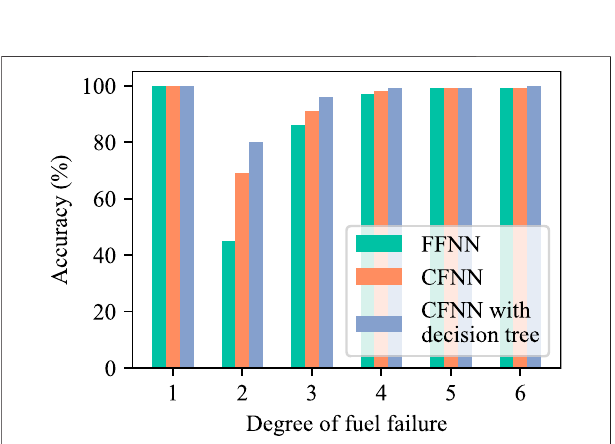
FIGURE 5 | Comparison of accuracy between the previous FFNN method and the improved